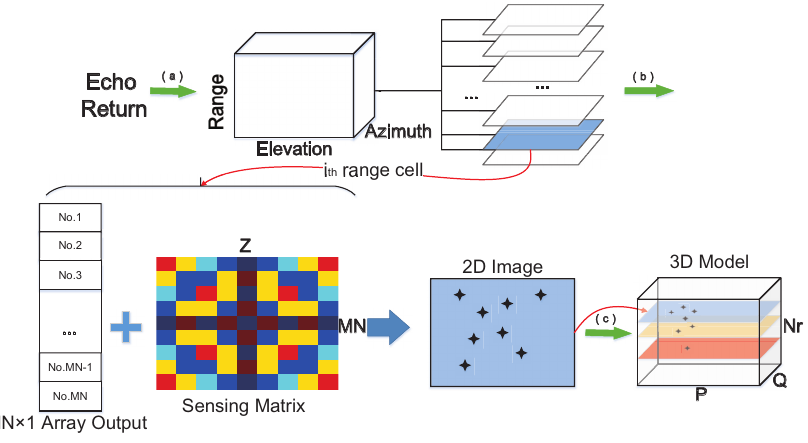
Figure 3. Workflow of the proposed 3D imaging algorithm. ( a ) Range compression and channel separation; ( b ) 2D off-grid imaging in elevation and azimuth direction; ( c ) Formation of the 3D